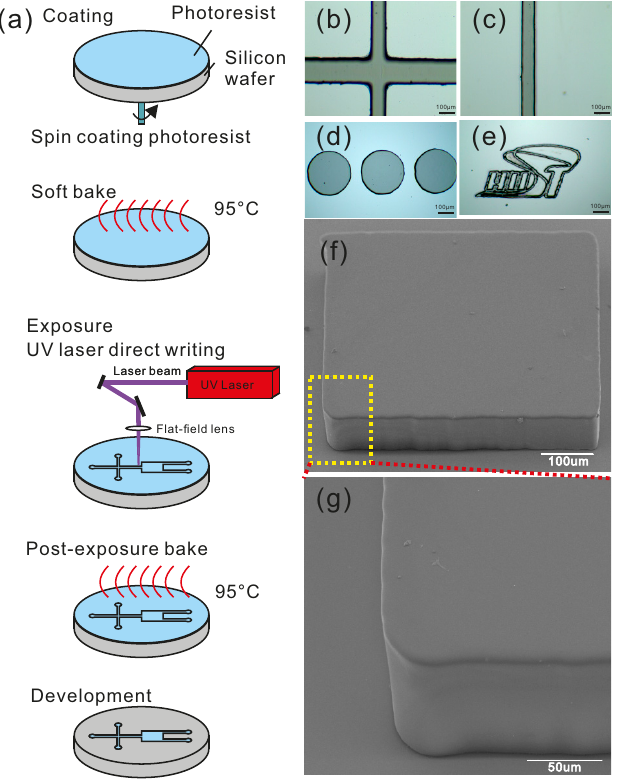
Figure 1. ( a ) schematic process of master fabrication; ( b – e ) top view images of the master structure by optical microscope; and ( f , g ) side view images of the master structure by scanning electron microscopy (SEM).